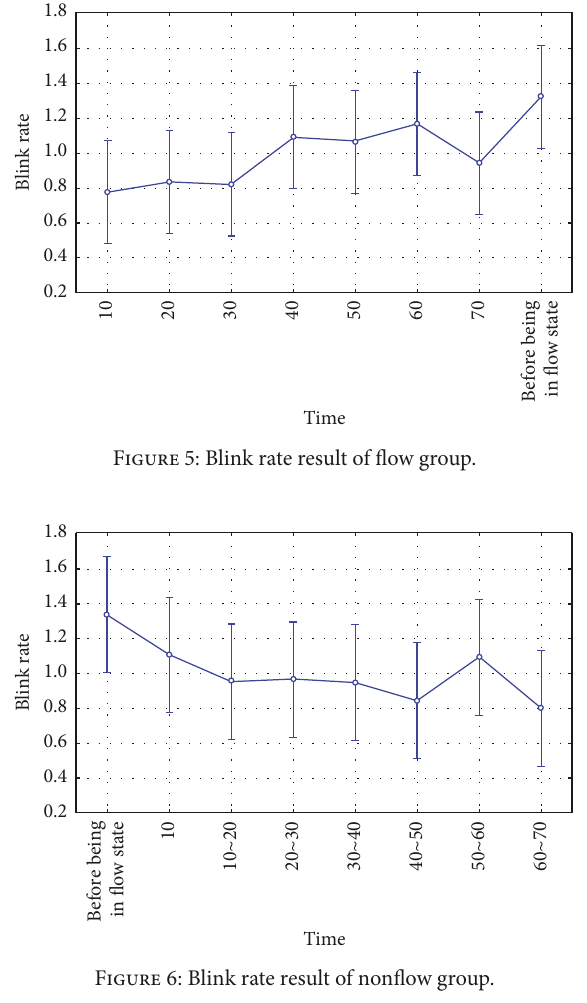
states. The results of our study confirmed all four